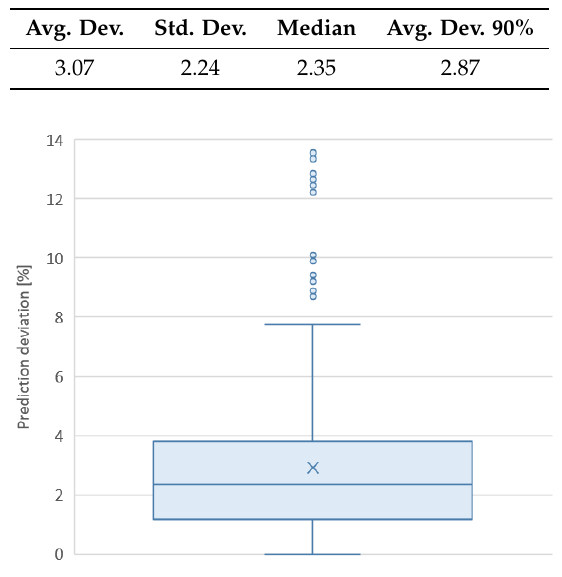
Table 1. Average deviation (as %) of the prediction of the Young’s modulus.